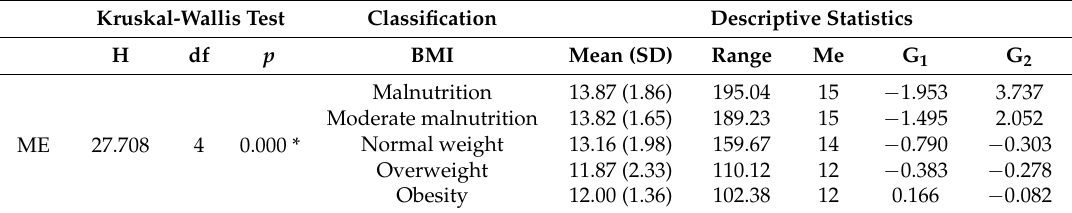
Table 8. Kruskal-Wallis test and descriptive statistics for social-emotional skills according to BMI for the sample of boys. Kruskal-Wallis Test